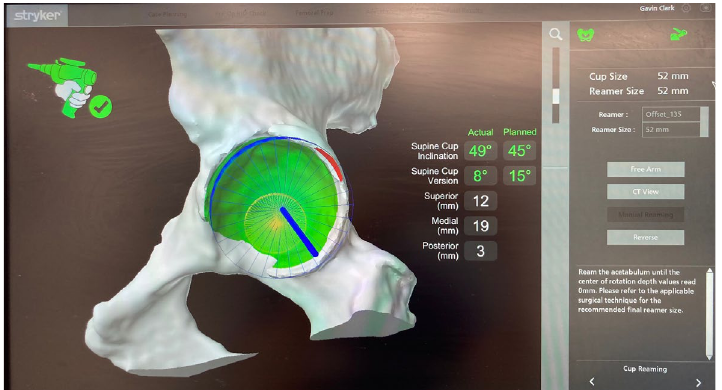
Figure 9. MAKO robotic arm attached to an acetabular reamer to provide feedback and guide surgical reaming of the acetabulum intraoperatively.